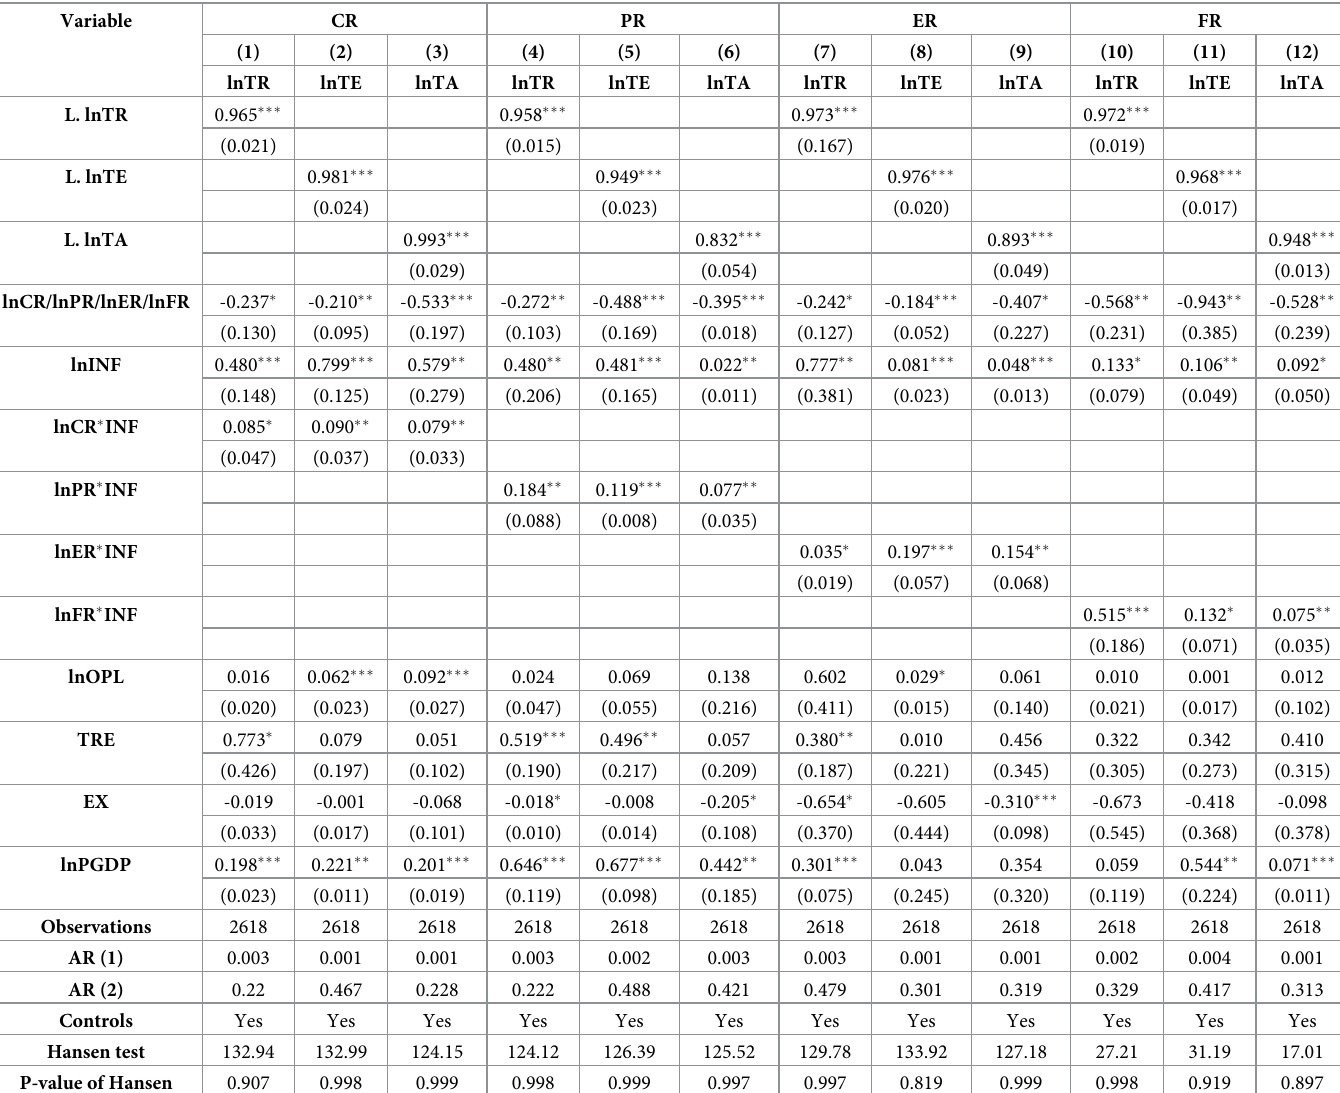
Table 12. The moderating effects of